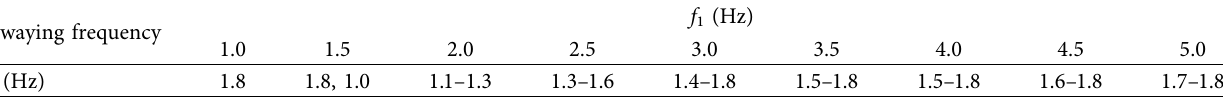
Figure 33: The structural VDV of models with different f Table 10: The max structural VDV value corresponding swaying frequencies.